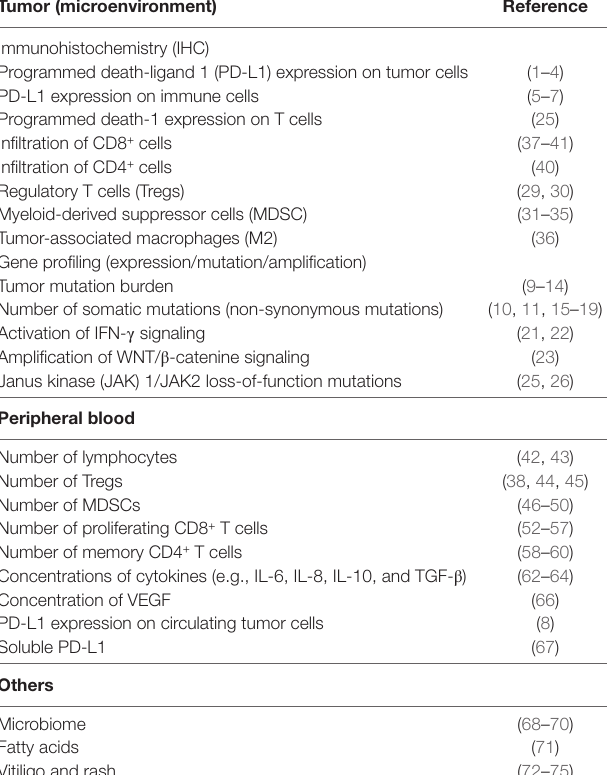
TaBle 1 | Biomarkers for metastatic melanoma patients treated with immune checkpoint inhibitor therapy. Tumor (microenvironment)